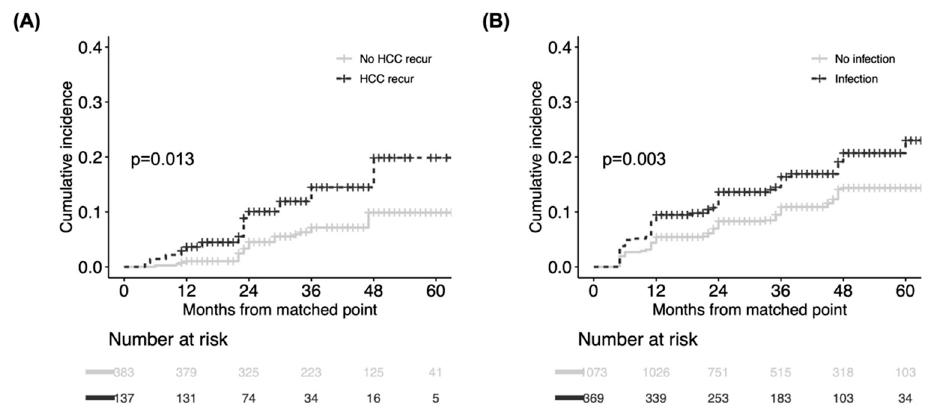
Figure 4. Comparison of cumulative incidence of CKD between matched groups according to presence/absence of post-transplant risk. ( A ) HCC recurrence and ( B ) infection. CKD was compared from matched time points between two groups. CKD, chronic kidney disease.